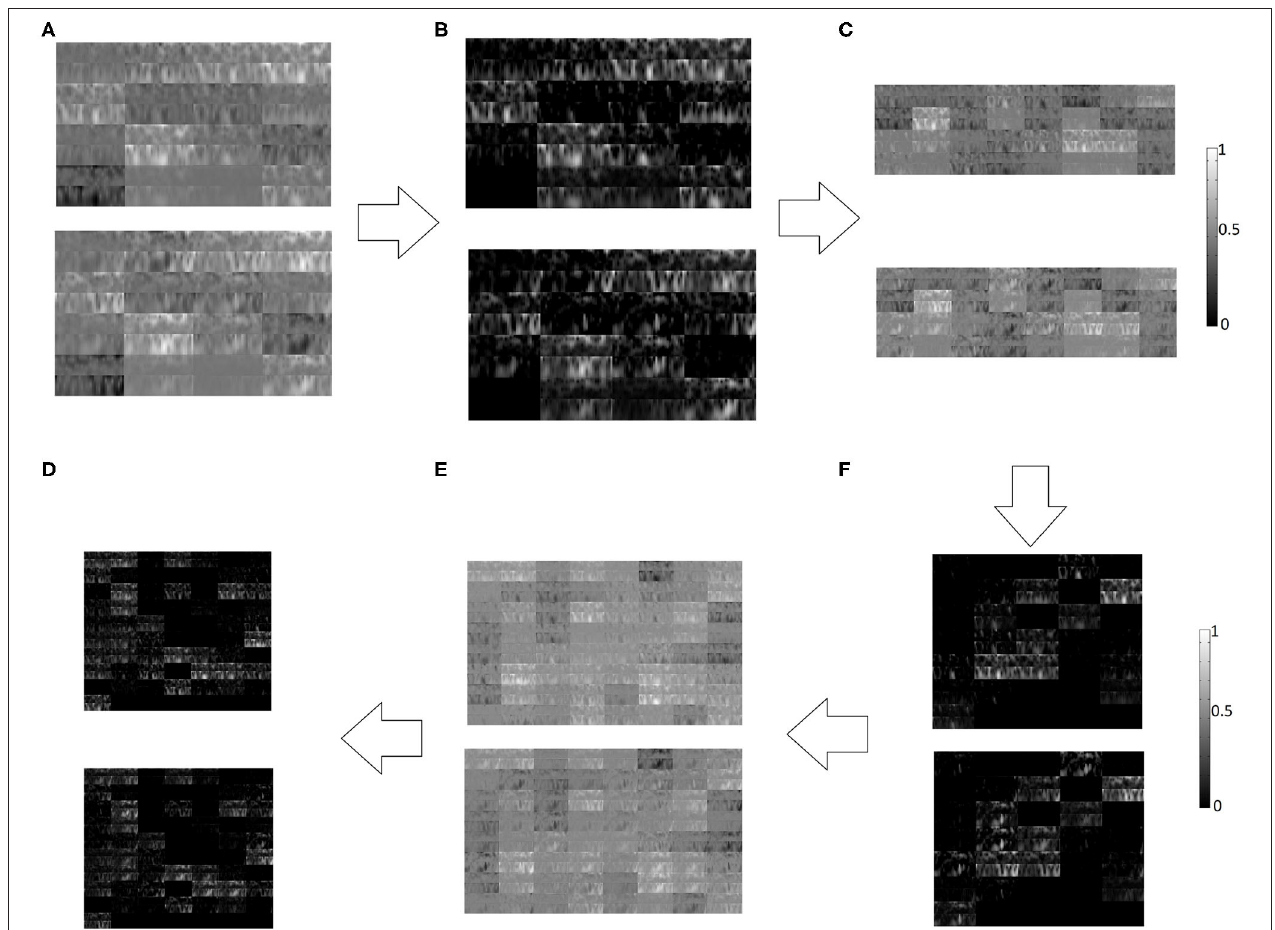
FIGURE 7 | Left hand MI (Top panel) and right hand MI (Bottom panel) features generated at different layers of CNN, (A) Convolutional Layer 1, (B) ReLU Layer 1, (C) Convolutional Layer 2, (D) ReLU Layer 2, (E) Convolutional Layer 3, (F) ReLU Layer